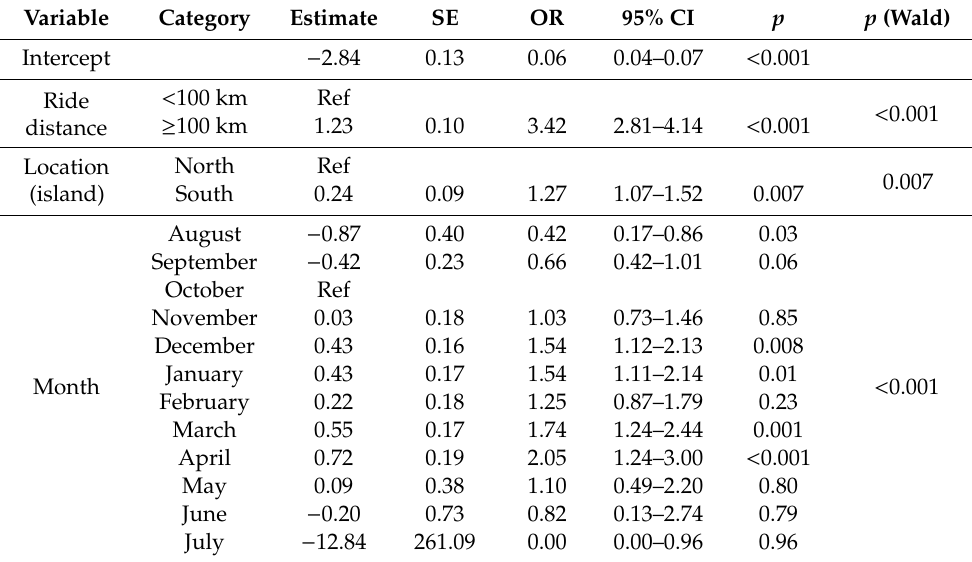
Table 5. Multivariate logistic regression model of associations between ride elimination (No / Yes) due to lameness only and predictor variables; ride distance, location and time of year.